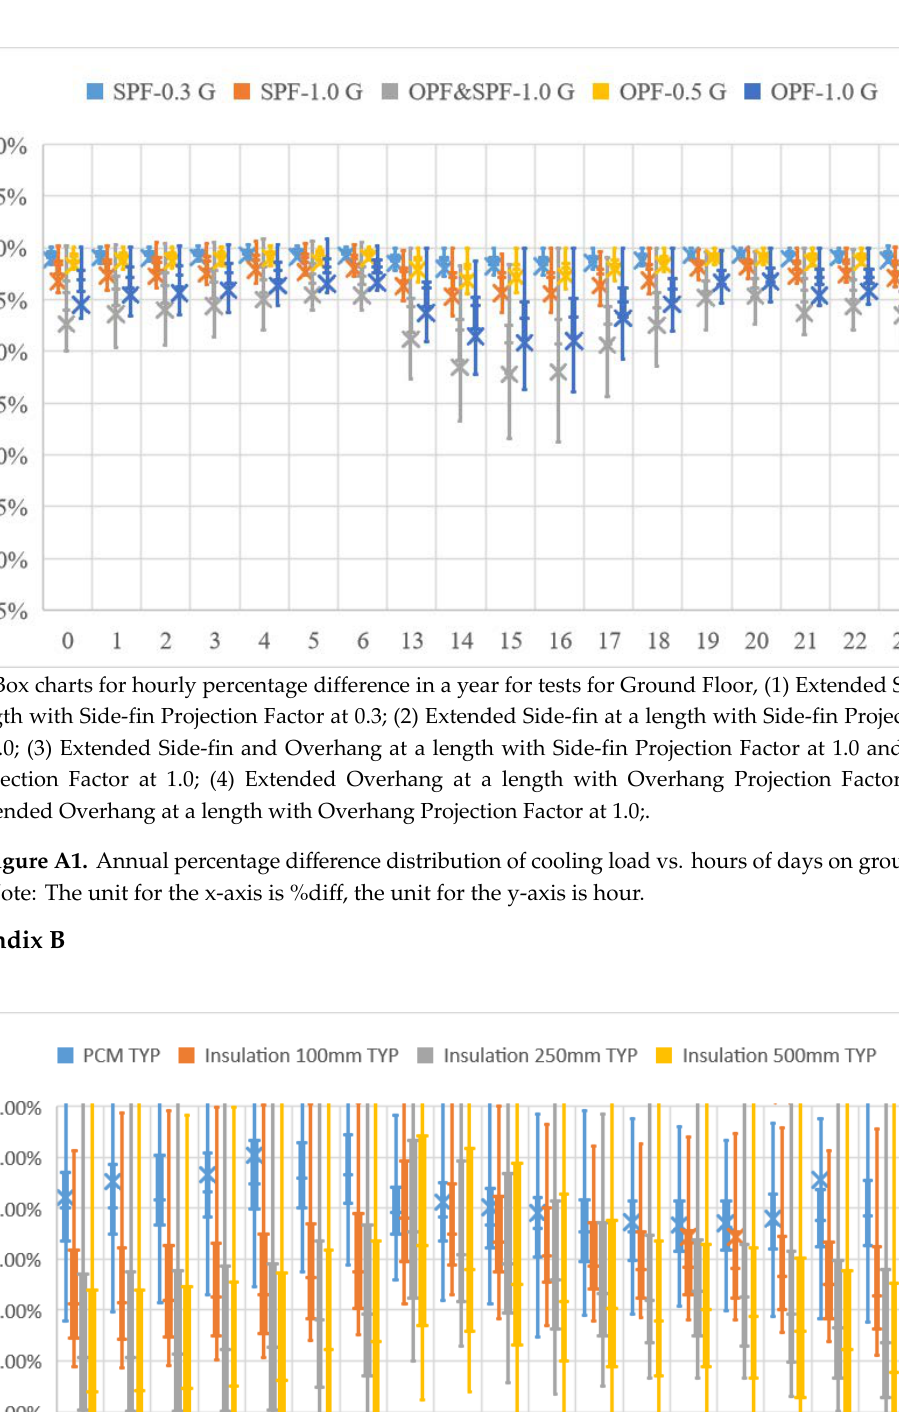
( d ) Box charts for hourly percentage difference in a year for tests for Ground Floor, (1) Infiltration decreased to 0.3 ach; (2) Infiltration decreased to 0.6 ach; (3) Window-to-Wall Ratio reduced to 14.9%.